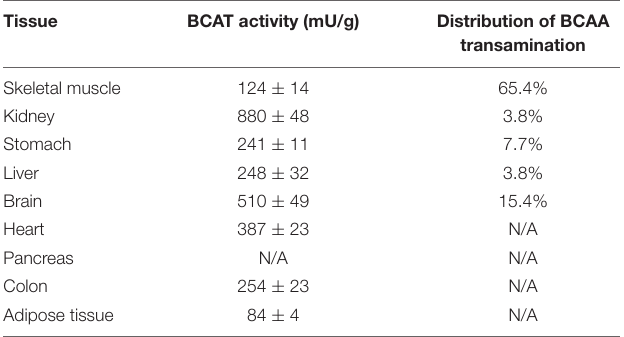
Table re-drawn and modified from Suryawan et al. (1998). BCAT, branched chain aminotransferase; BCAA, branched-chain amino acids; g, grams of tissue; mU, milliunits; N/A, not applicable.